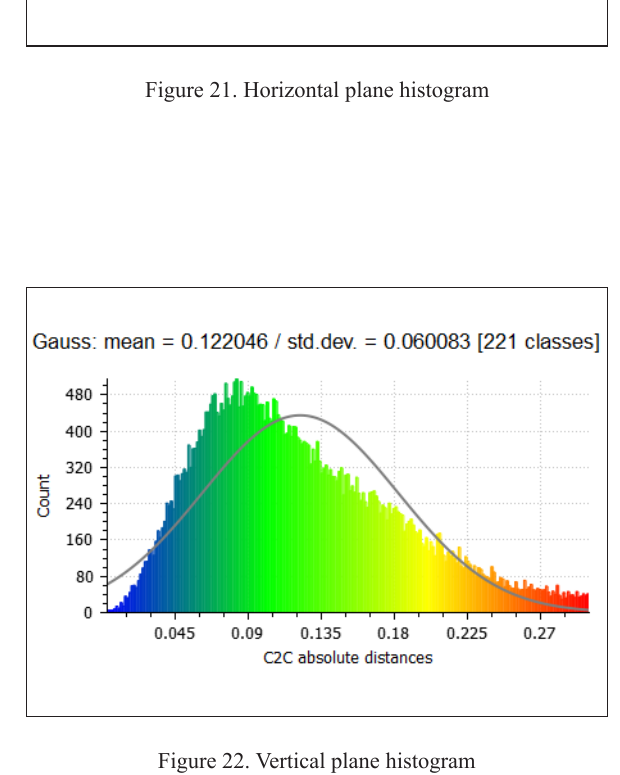
Figure 22. Vertical plane histogram